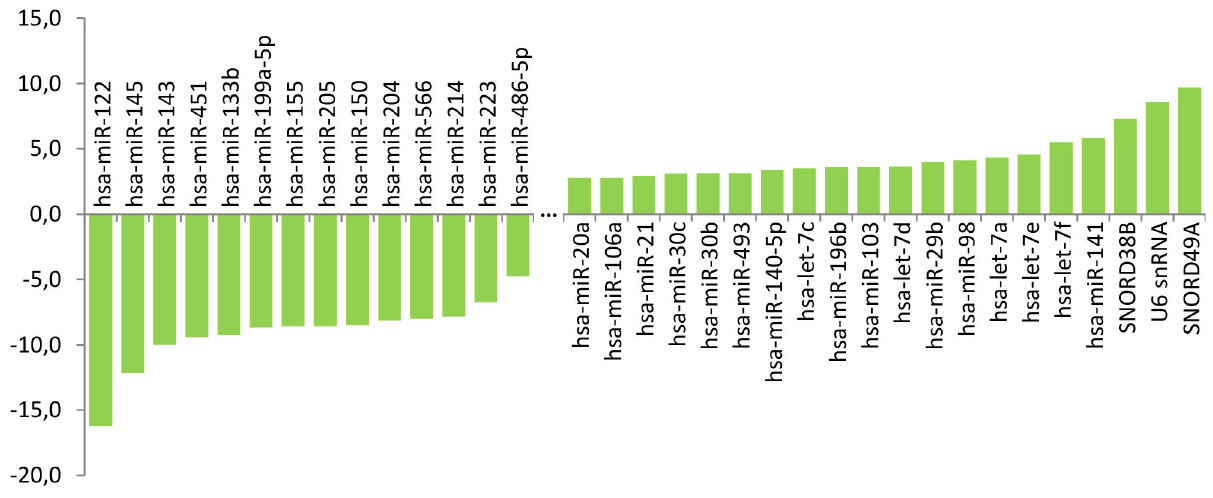
Figure 4. Distribution of miRNA subsets specifically either secreted into the medium (left) or retained in the cytoplasm (right) of the A2182 human lung cancer cell line. Numbers correspond to the logarithm of fold change of miRNA expression level detected in cells versus conditioned